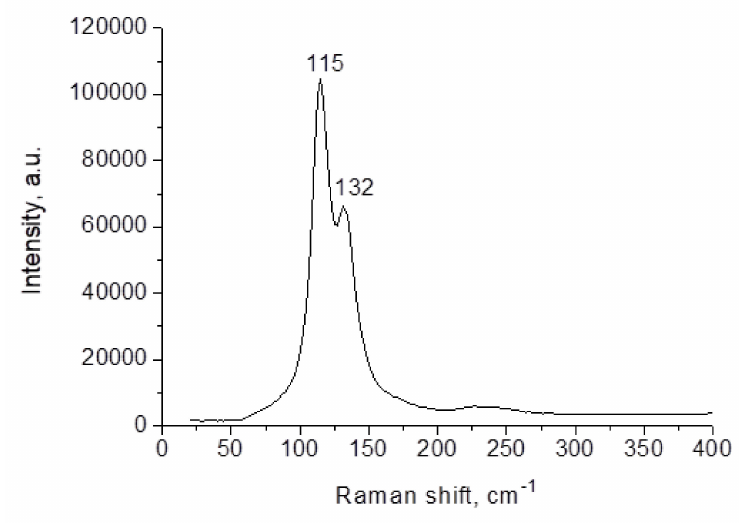
Figure 6. Raman spectrum of (HpipeH 2 )I(I 3